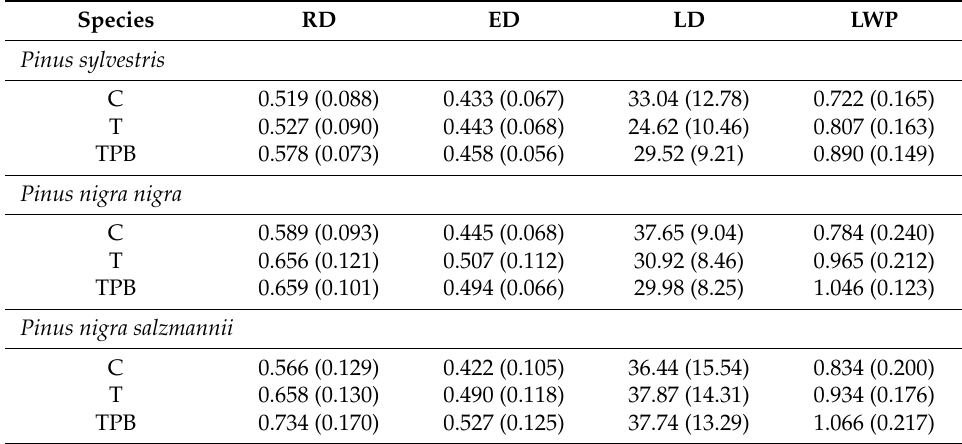
Table 2. Arithmetic mean and standard deviation (between brackets) of RD (ring density, in g cm − 3 ), LD (latewood density, in g cm − 3 ), ED (earlywood density, in g cm − 3 ), and LWP (percentage of latewood, in %) from the time of trial installation to 2012.